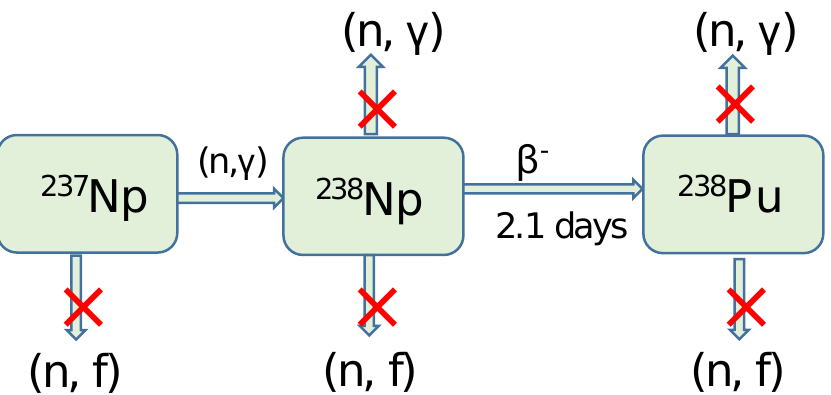
Figure 1. Chain of isotopic transformations under neutron irradiation of 237 Np. The symbol «X» designates the undesirable processes for 238 Pu production.